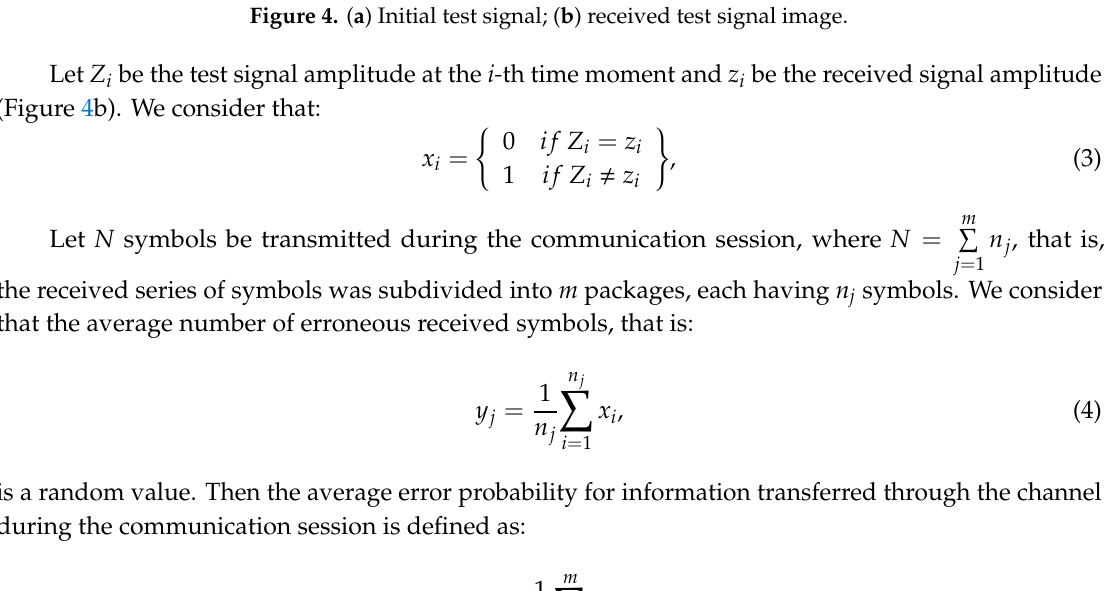
Figure 4 . ( a ) Initial test signal; ( b ) received test signal image. Figure 4. ( a ) Initial test signal; ( b ) received test signal